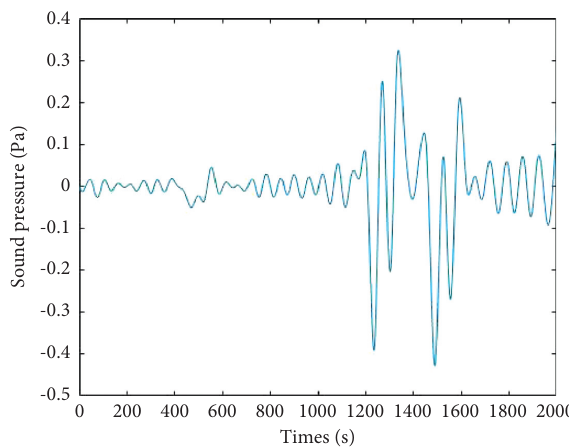
Figure 16: MEEMD reconstruction signal error of the simulation signal.